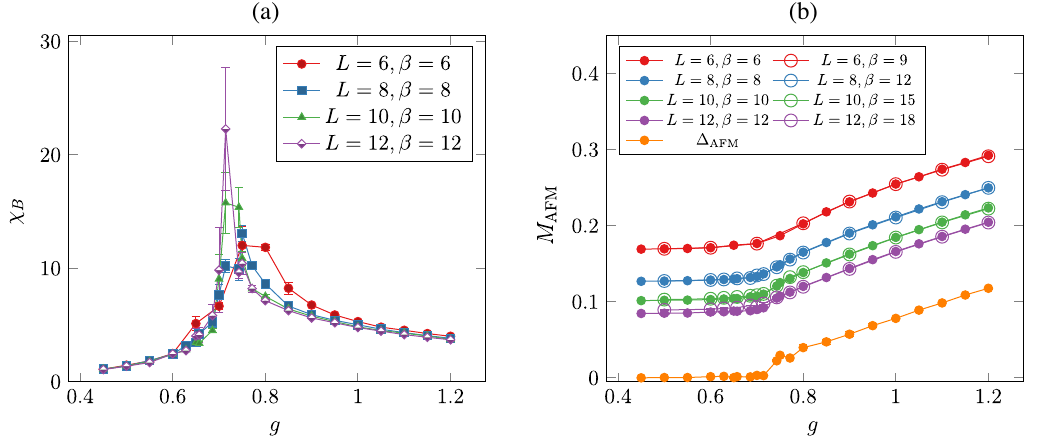
FIG. 2. Orthogonal semimetal confinement transition. Evolution of the (a) flux susceptibility χ M across the phase transition separating the OSM and the confined AFM as a function of the transverse field g for a fixed hopping AFM amplitude t ¼ 0 . 2 . Different curves correspond to a set of increasing system sizes and inverse temperatures. Δ extrapolation of the finite-size data to the thermodynamic